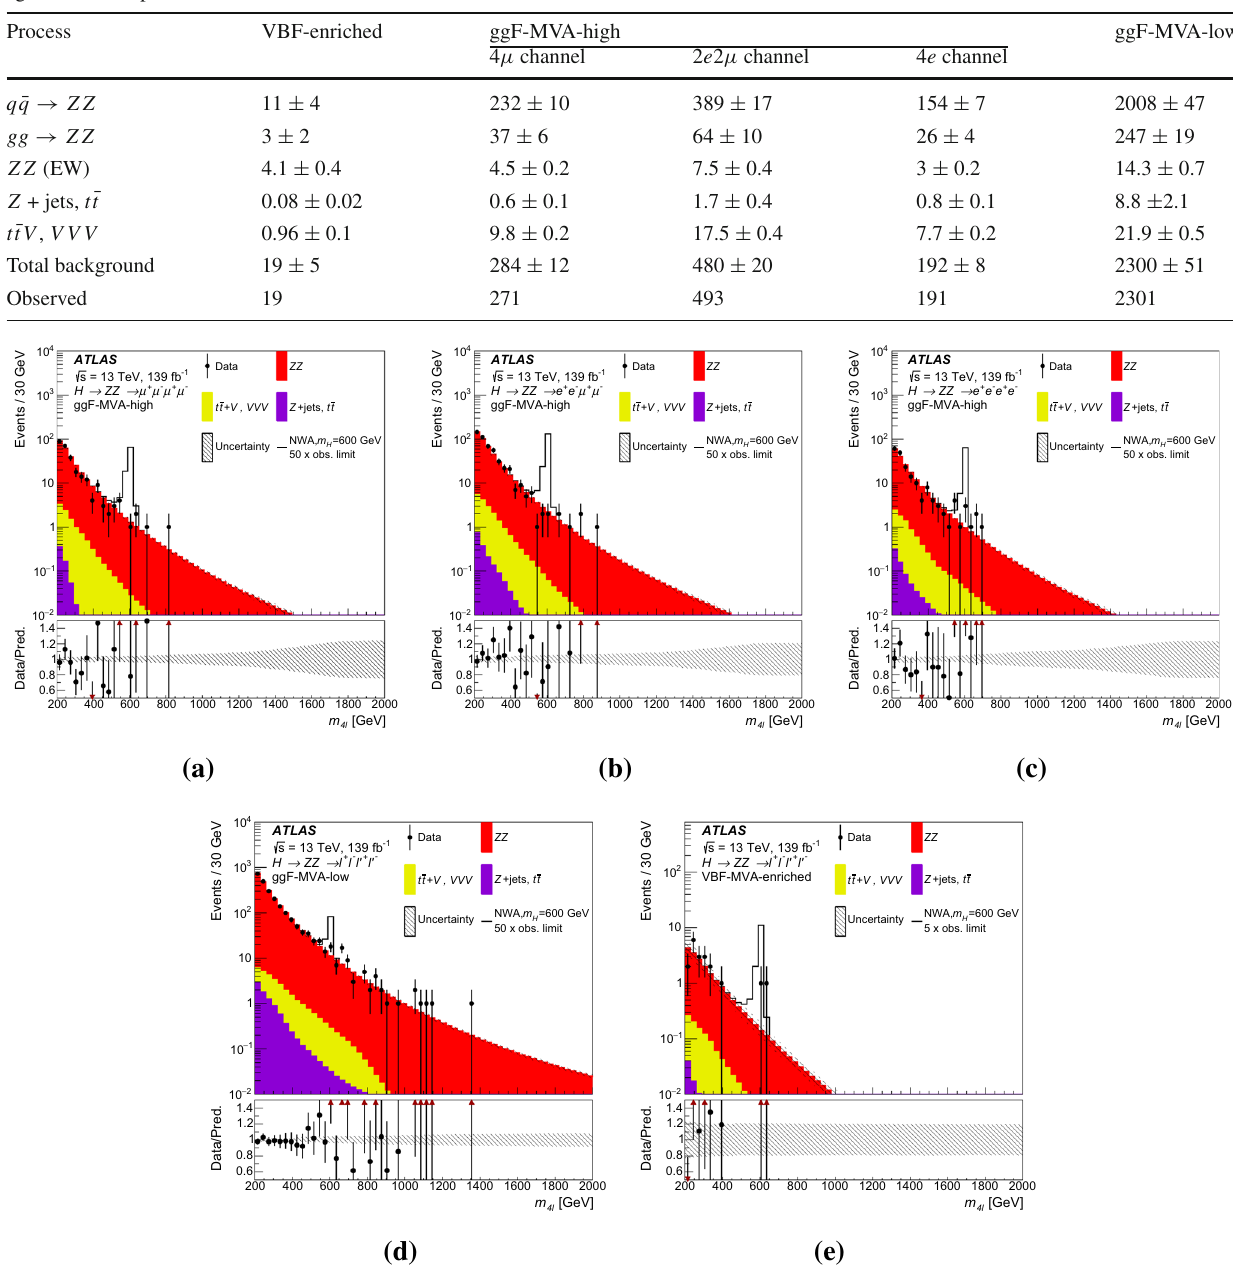
Table 3 Expected and observed numbers of events in the (cid:3) + (cid:3) − (cid:3) (cid:2)+ (cid:3) (cid:2)− final state for m 4 (cid:3) > 200 GeV, together with their uncertainties, for the VBF-MVA-enriched, ggF-MVA-high and ggF-MVA-low cat- egories. The expected numbers of events, as well as their uncertain-